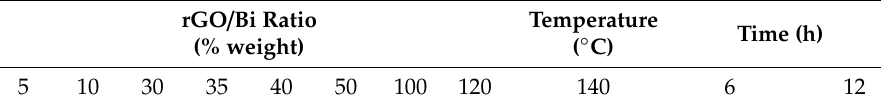
Table 6. Experimental conditions used to obtain rGO / Bi